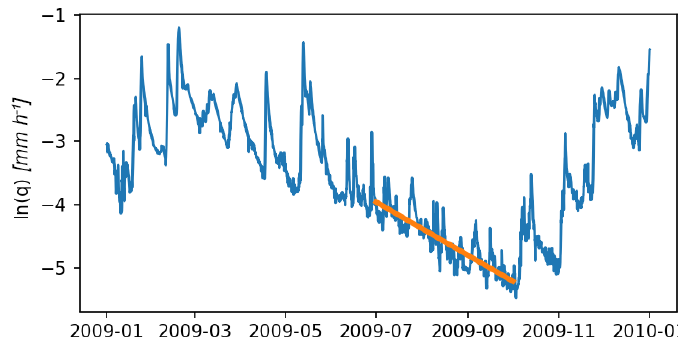
Figure 1. During the recession period, the Ourthe has a timescale of 1772h for groundwater depletion, acting as a linear reservoir. Superim- posed on the recession we see faster processes with much shorter